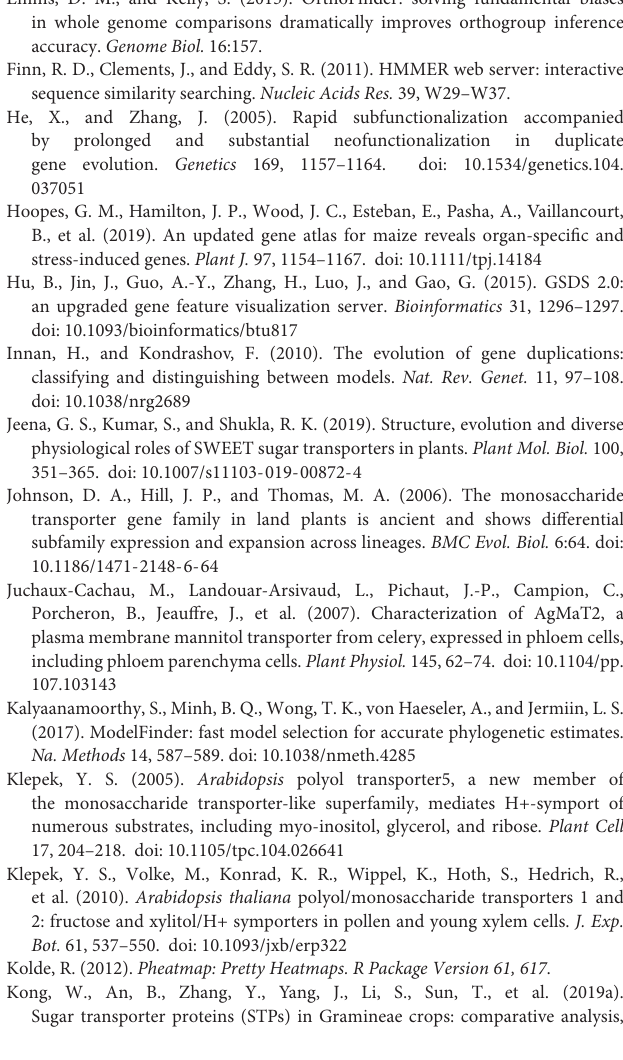
FIGURE S1 | An internal repeat of PLT genes. The proteins themselves are represented by the dark diagonal lines, and the duplicated regions are represented by the above the dark diagonal lines. FIGURE S2 | 2D models of 6h7d.1.A and 6n3i.1.A. FIGURE S3 | Sketch map of maize tissues. TABLE S1 | Detailed information on the PLT genes in seven tested Gramineous crops. TABLE S2 | Nine orthogroups among the seven tested Gramineous crops. TABLE S3 | Statistics of the four types of orthologs between different Gramineous crops. TABLE S4 | Orthologs list among different Gramineous crops. TABLE S5 | 3D structure prediction results of rice PLTs proteins. TABLE S6 | Genes and Pearson’s r -values in the co-expression network. TABLE S7 | GO enrichment of genes in the co-expression